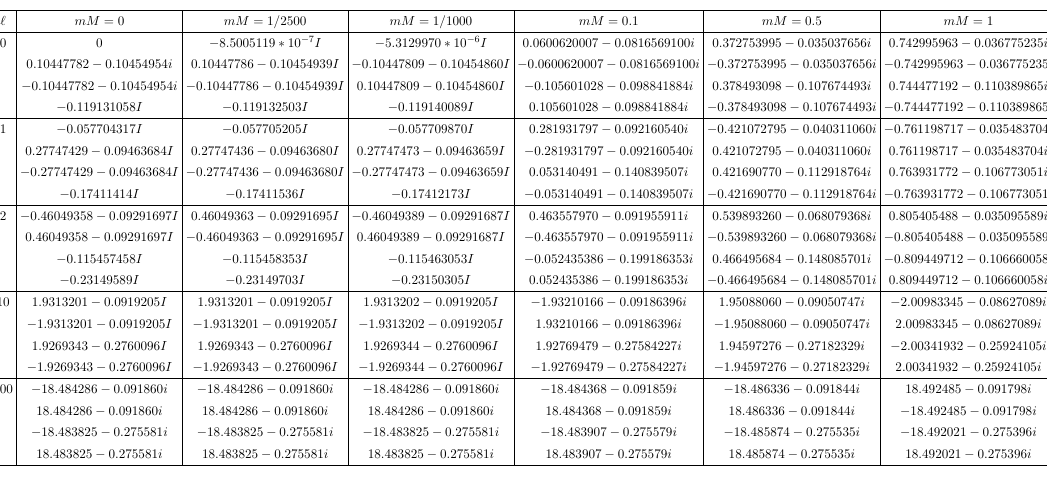
Table 1 . The QNFs ωM for massive uncharged scalar fields in the background of RN dS black holes with Λ M 2 = 0 . 01 , Q/M = 1 / 10 , and different values of ‘ .